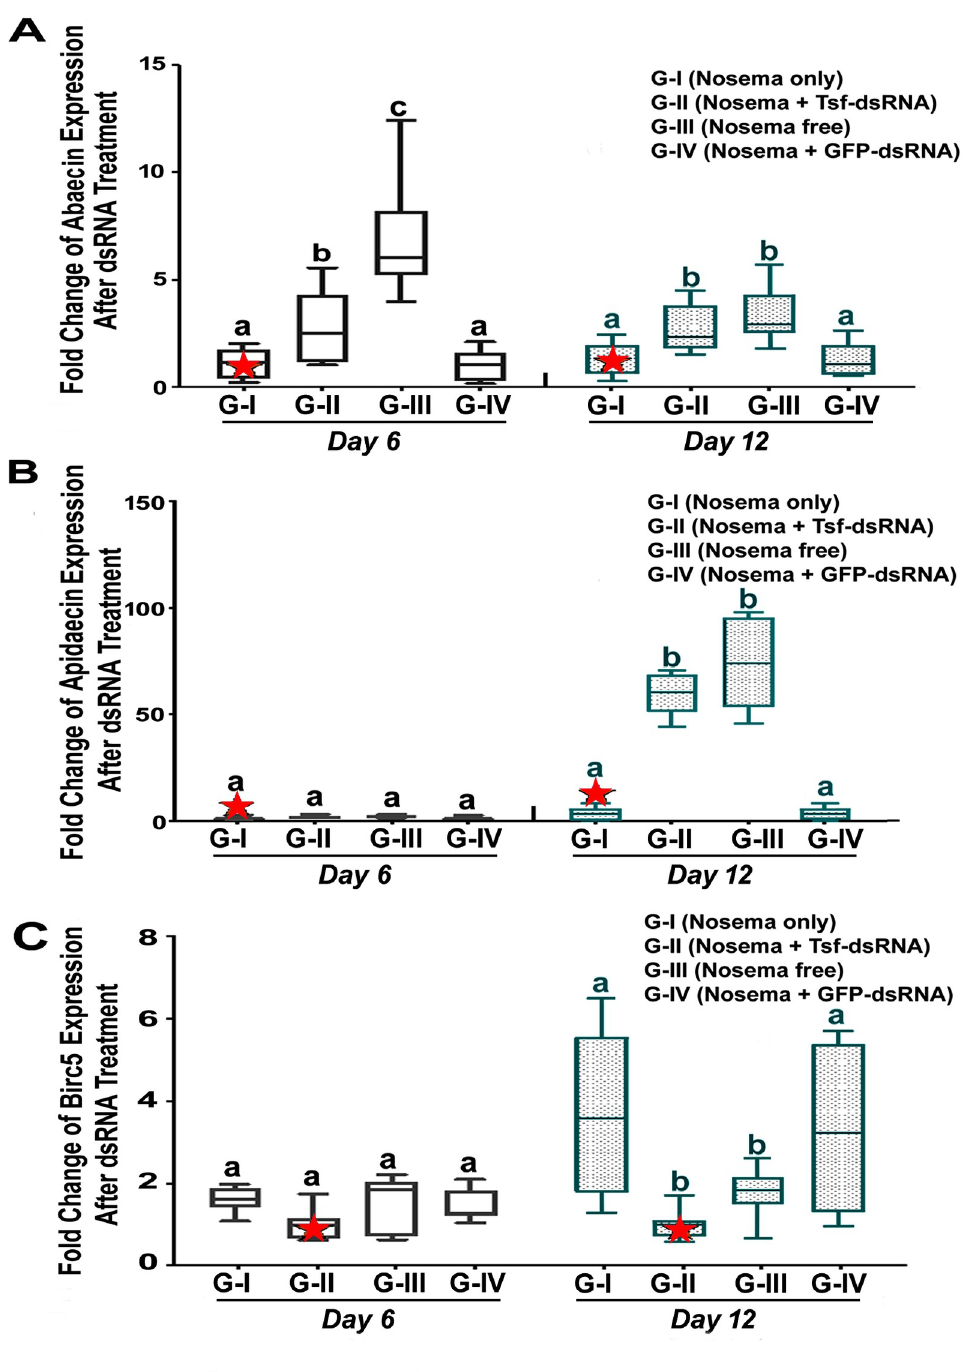
Fig 9. Time dependent transcription profiles for genes encoding antimicrobial immune peptides. (A) Apidaecin , (B) Abaecin , and (C) for gene encoding inhibitor of apoptosis Birc5 . The relative expression was expressed as an n-fold difference relative to the calibrator (marked by a star) by 2 – ΔΔ Ct method. A star denotes a calibrator and the different lower-case letters above bars indicate the statistically significant difference among different groups ( P � 0.05, ANOVA and Tukey´s tests).